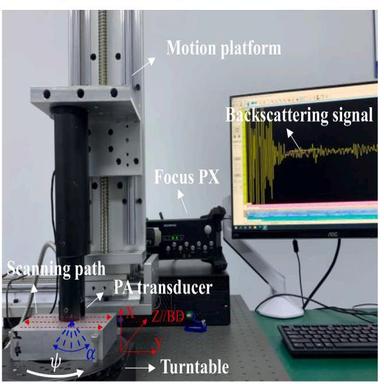
PA experimental setup.